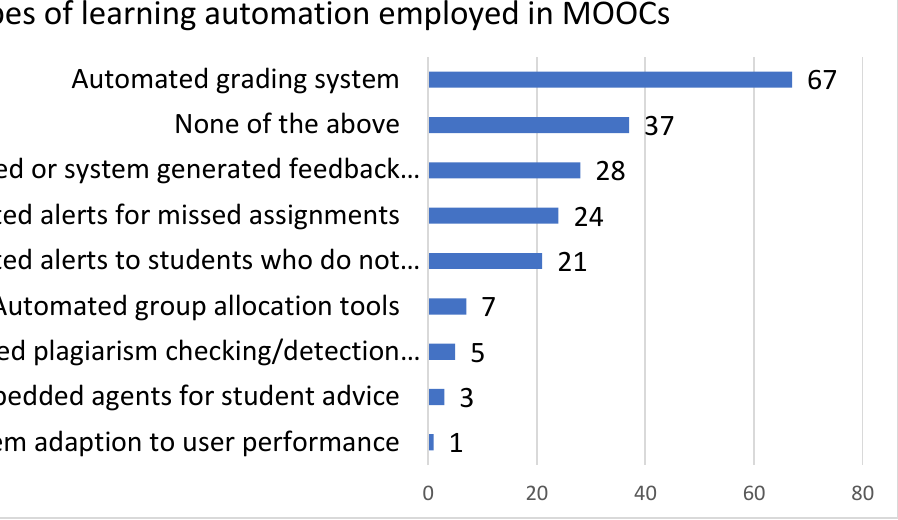
Figure 6. Number of MOOCs that offer different types of learning system automation and adaptation